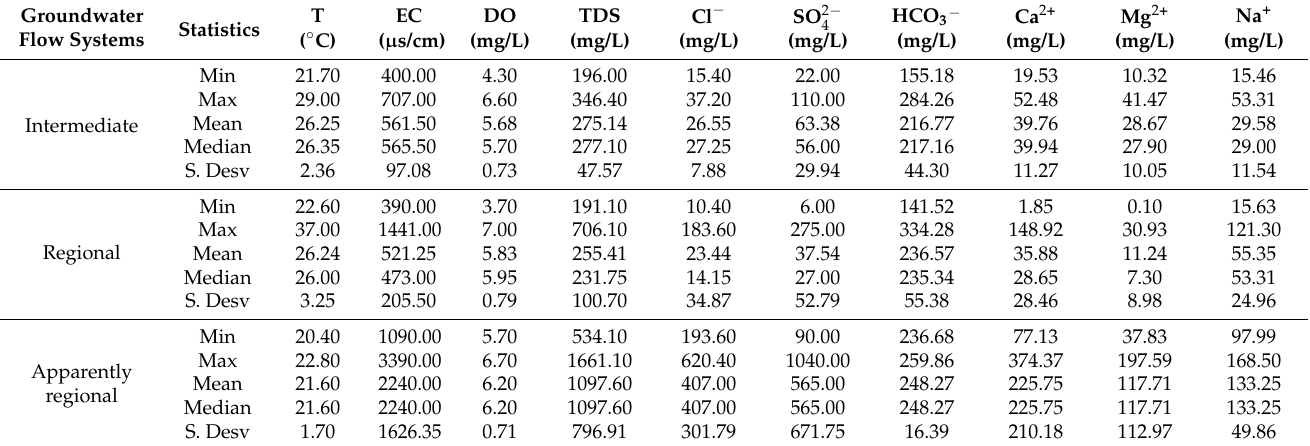
Table 3. Clustering of flows as a result of the cluster analysis for the year